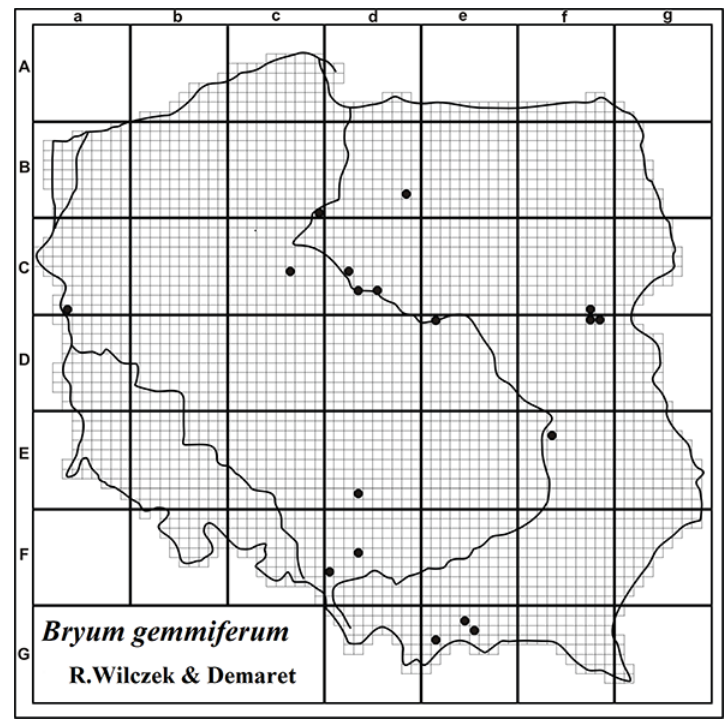
Figure 2 Distribution of Bryum gemmiferum in Poland in the ATMOS grid.